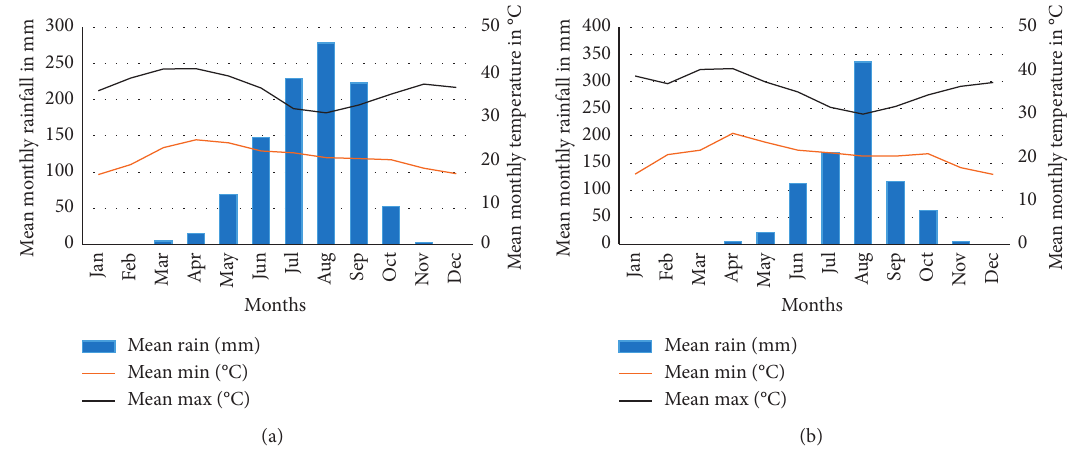
Figure 2: Long-term monthly average rainfall and daily mean minimum and maximum temperatures (a) and mean daily temperature and annual rainfall of 2017 calendar year